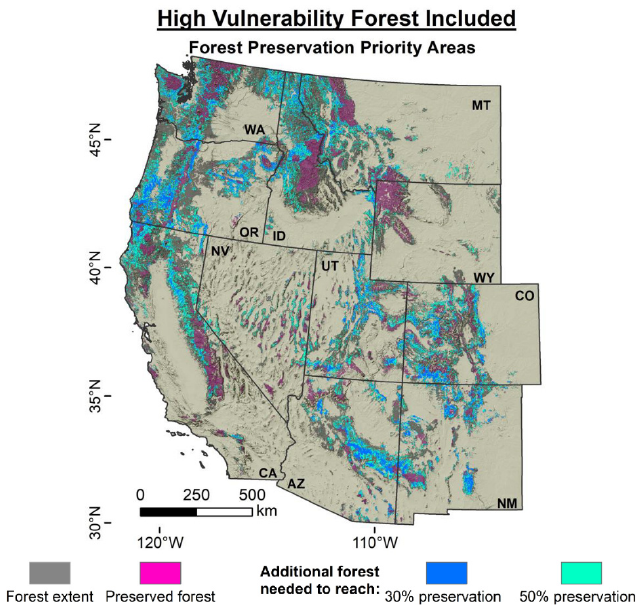
Figure 4. Forestlands that are currently preserved, and additional areas identified as high priority for protection of biodiversity and forest carbon for climate mitigation across the western U.S. Adapted from [5].